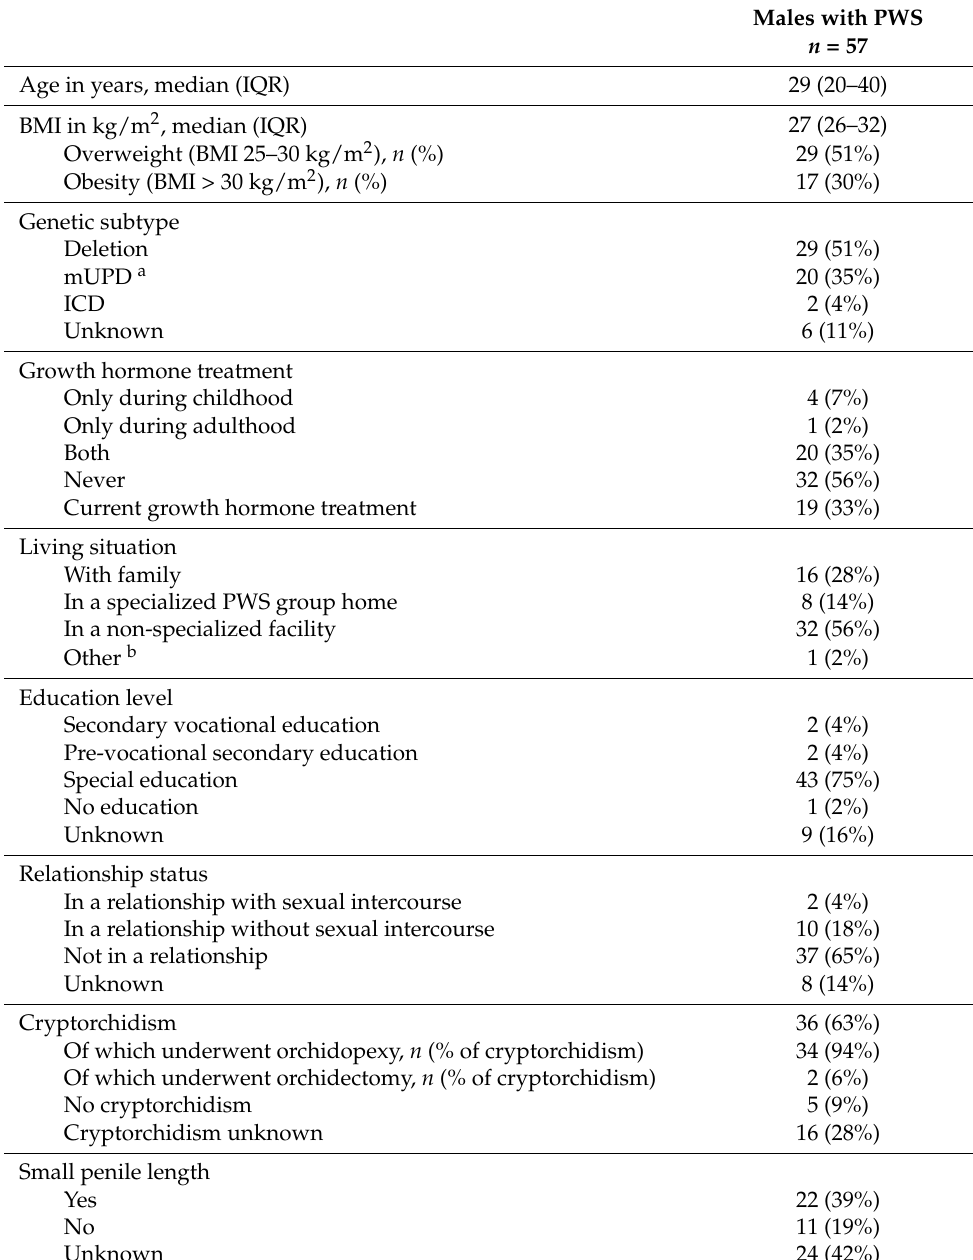
Table 1. Baseline characteristics of 57 adult males with Prader-Willi